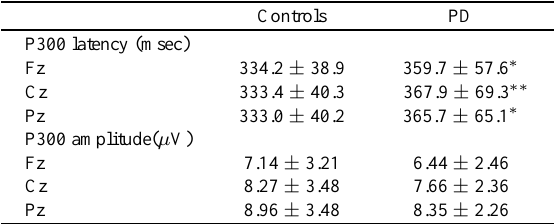
Comparison of P300 between controls and Parkinson’s disease pa-